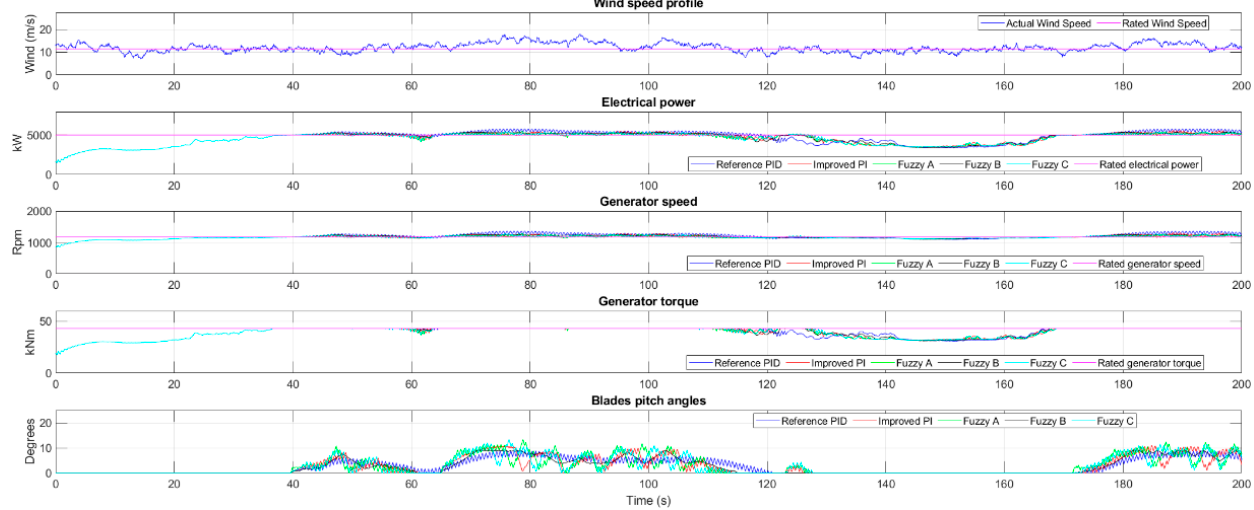
Figure 14. Comparison of the evaluated controllers for a wind profile of 13 m/s. Table 7. Indexes for simulations with wind profile 1 (13 m/s A).